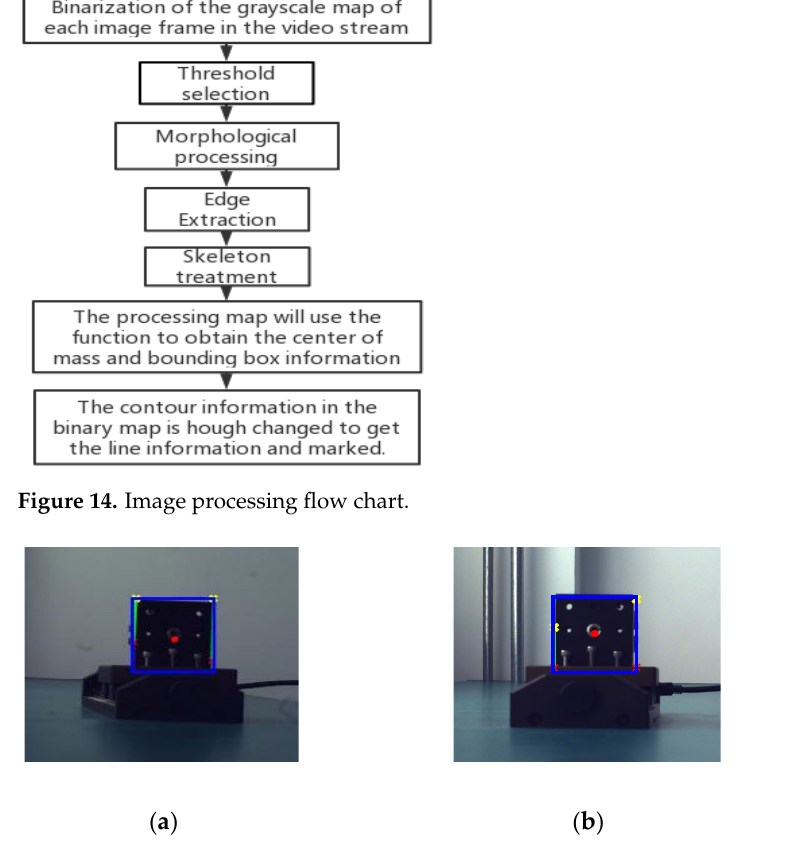
Figure 15. Real target bounding box ( a ) and center-of-mass point extraction ( b ).